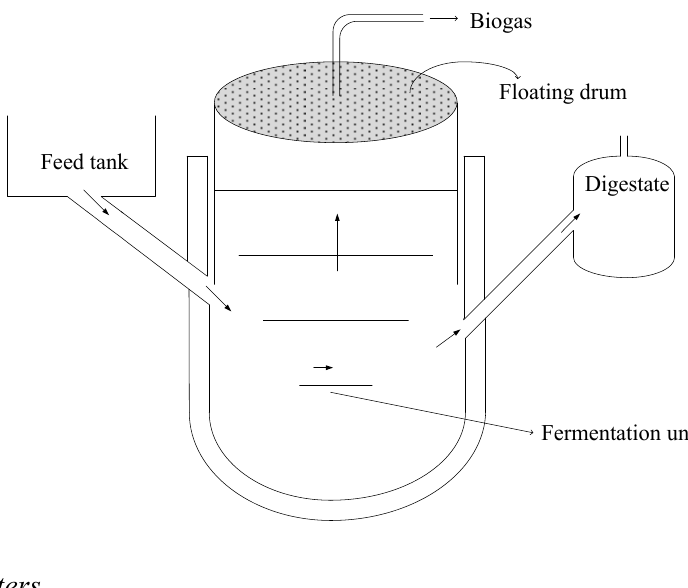
Figure 2. Schematic sketch of a floating drum digester.